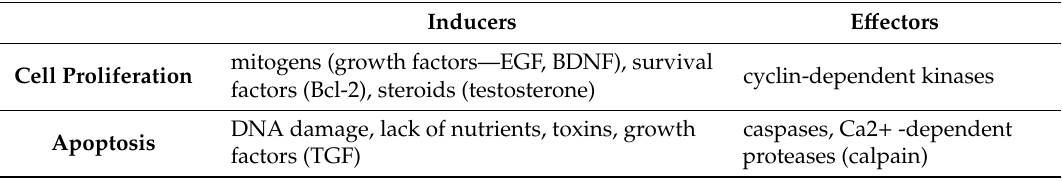
Table 1. Examples of inducers and e ff ectors of cell proliferation and apoptosis [43,48,49]. Inducers E ff ectors Cell